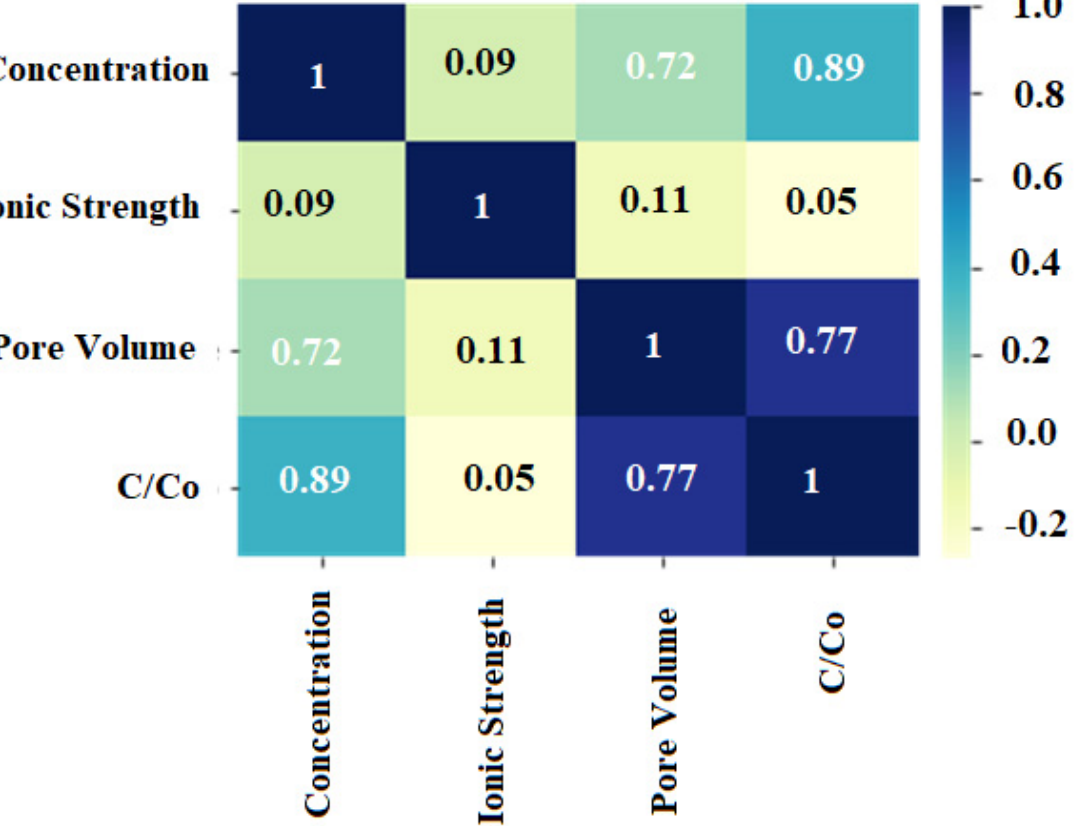
Figure 4. Heated Correlation plot.